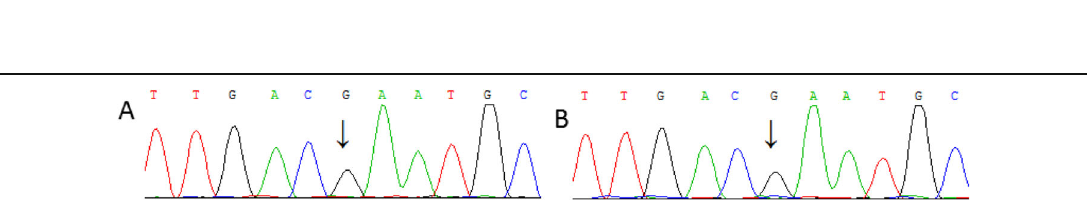
Fig. 5 cDNA Sanger Sequencing results of the patient and the control. a the control; b The patient. The arrow indicates the c.3217 position of the FBN1 gene, only wild G base was found at the position in both the patient and